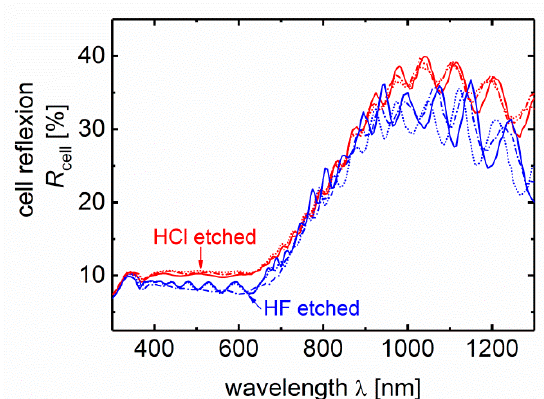
Figure 4. Cell reflection measurements of various HF (blue lines) and HCl (red lines) etched samples from series 1.